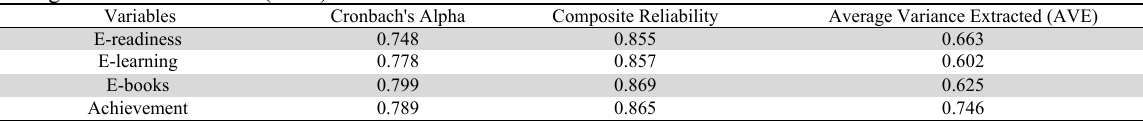
Average Variance Extracted